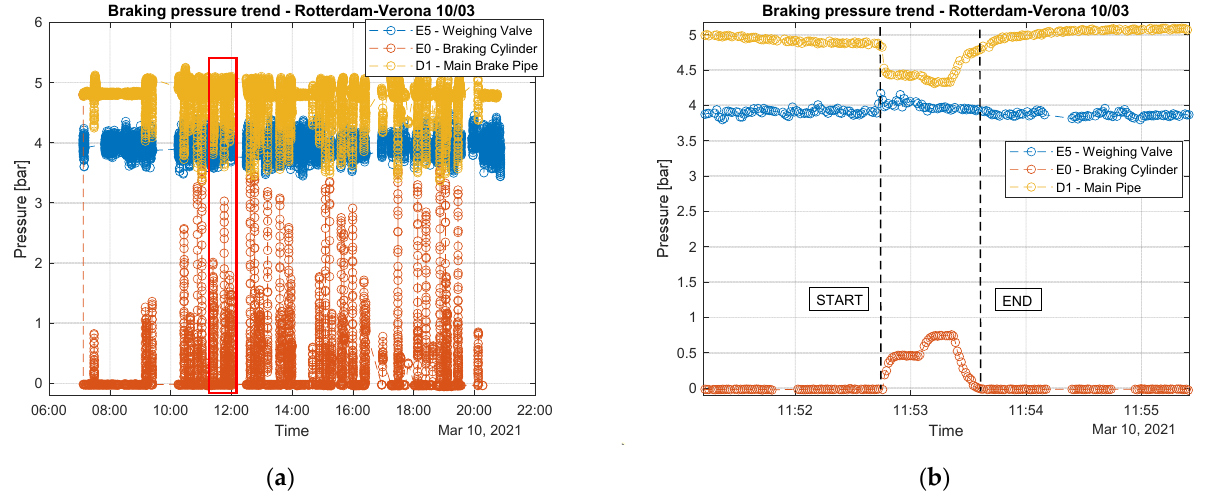
Figure 17. Pressure measures during a wagon travel ( a ) Pressure history ( b ) Pressure variation during a braking event.